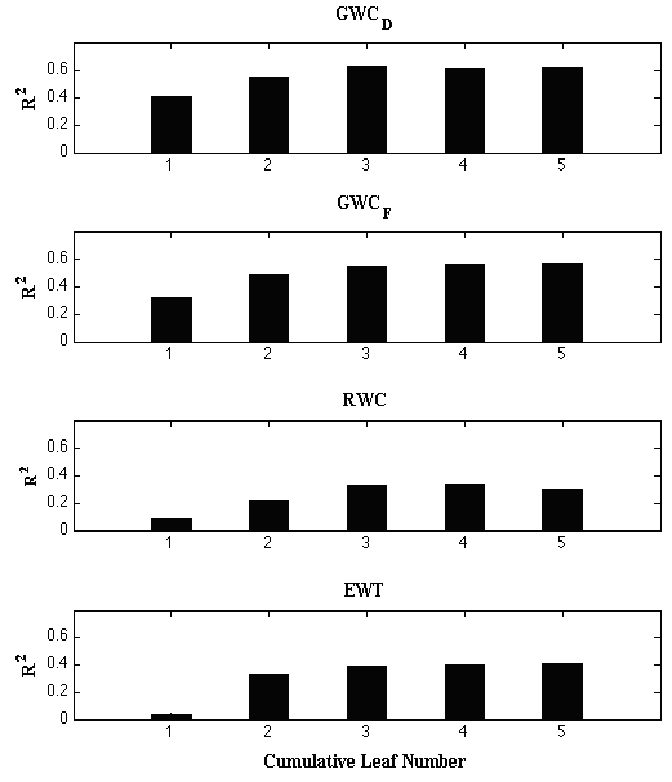
Figure 7. R 2 for the relationships between NDII 2020 and water-related properties for the cumulative leaf